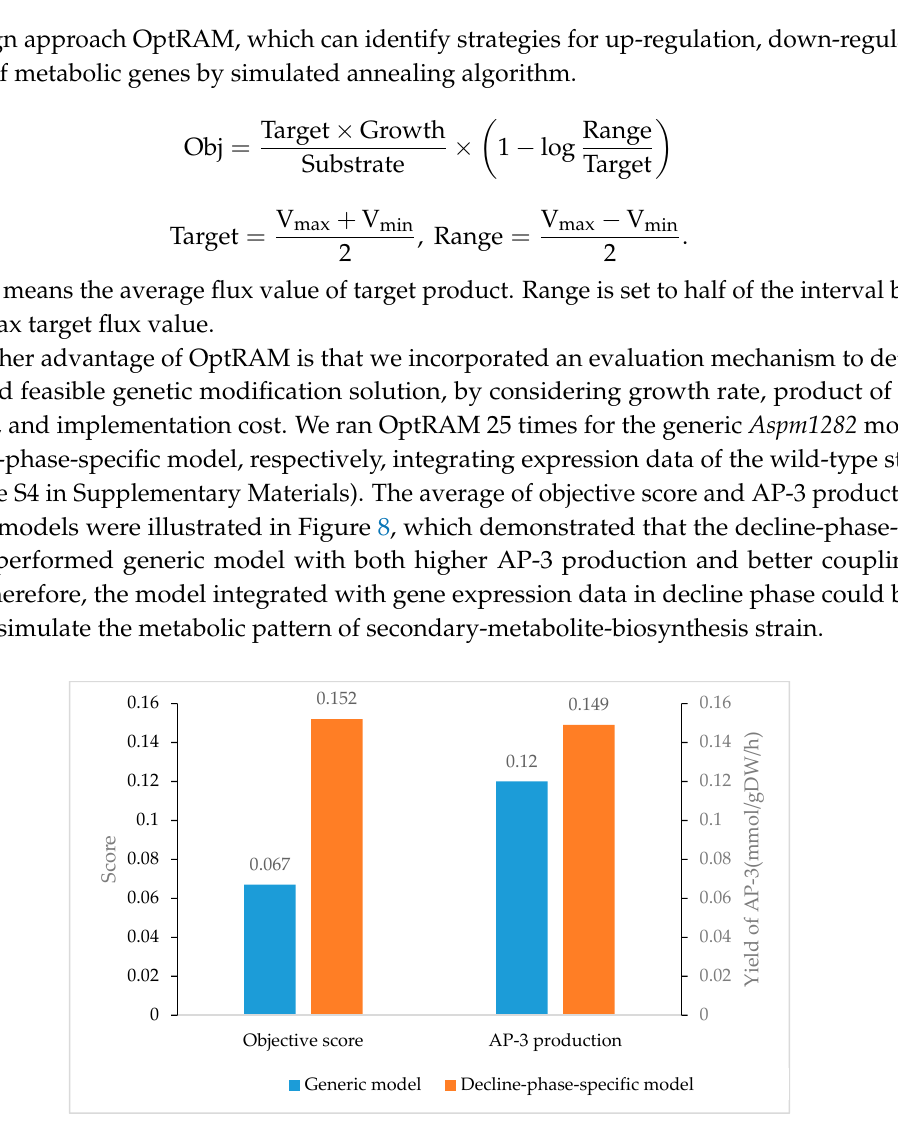
Figure 8. The mean objective score and mean AP-3 production predicted by generic Aspm1282 model and decline-phase-specific model.